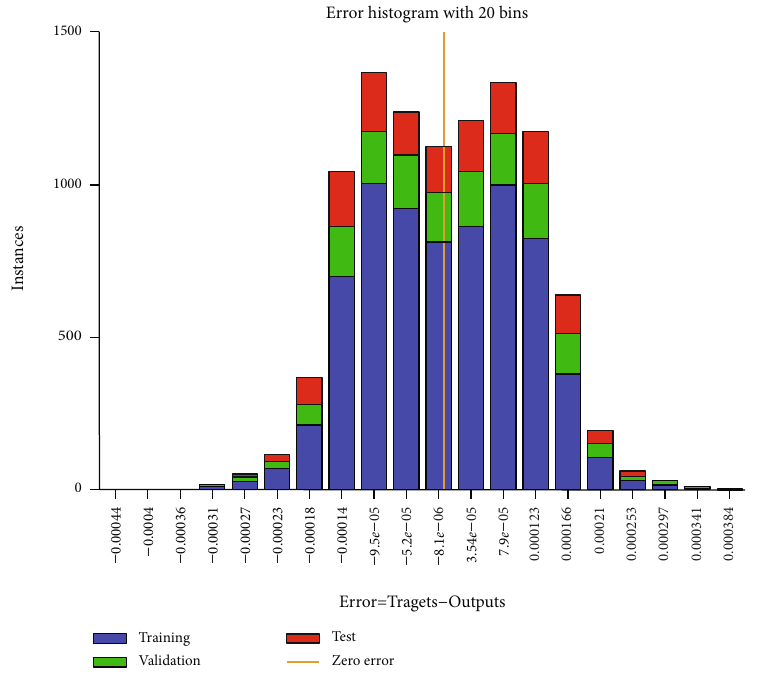
Figure 15: Error histogram of the DNN-based fuel fl ow controller.